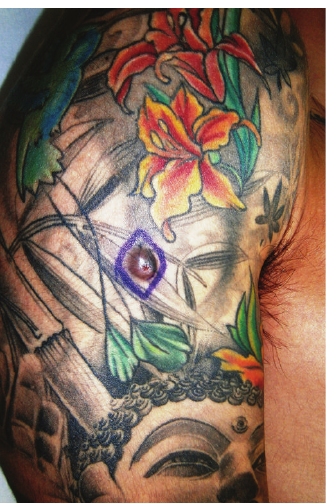
Figure 1: Dermatofibroma: 10 mm nodule arising in a black tattoo.